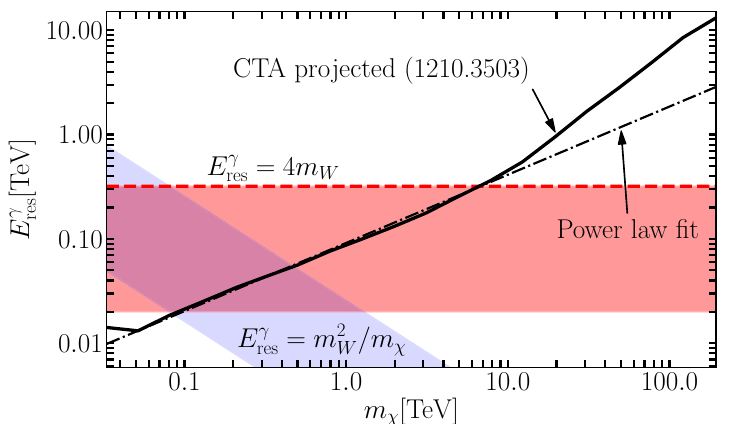
Figure 1 . Energy resolution of the CTA experiment (solid black line, from [9]), and the power-law = 0 . 0915 ( E γ / TeV) 0 . 653 (dash-dotted) with E γ = m χ . The dark-grey (red) and light-grey fit E γ res (blue) bands show where the intermediate and narrow resolution resummation applies, respectively. The boundaries are defined by m W [1 / 4 , 4] (intermediate resolution) and m 2